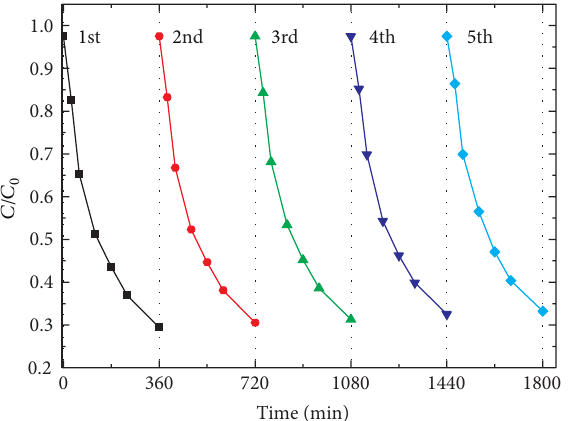
Figure 5: Photocatalytic activities of NS-TiO 2 NWs for atrazine degradation with 5 uses.